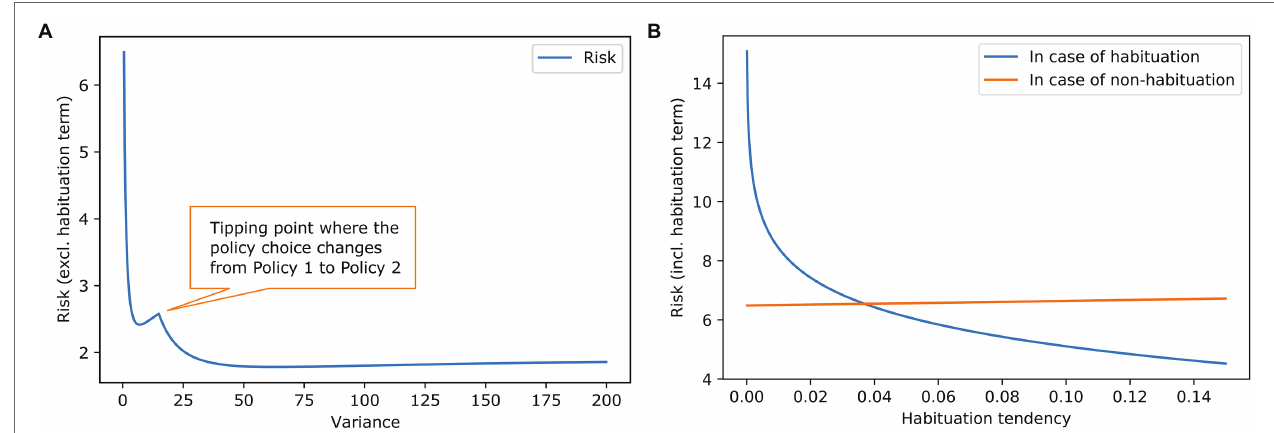
FIGURE 2 | Work stimulus scenario—effect of goal prior variance and habituation tendency on risk. (A) The blue line shows the risk term (excluding the habituation costs) dependent on the variance of the goal prior. We exclude the cost of habituation to show the influence of the goal prior shape on the policy choice. It can be seen, that risk is reduced if the goal prior is progressively flatter, because of the high mismatch between goal prior and attainable states in the policies. There is a tipping point where the policy choice for the agent changes. (B) The lines show the complete risk values (including the habituation costs) in case of habituation (blue) and in case of no habituation (orange) dependent on the habituation tendency. It is clear that risk for habituation gets smaller when the habituation tendency gets higher because the penalty for habituation is reduced. The orange line remains relatively constant which is intuitive because in case of no habituation the goal prior is not affected, and the penalty is not reduced. However, there is a slight increase in risk. This is due to our assumption that the agent strictly infers to not habituate. Before the inference, the agent had a (very) small preference for habituation which can be interpreted as a small value for keeping the option open. In the posterior q ( h ) though, the option is gone [in case of no habituation, it is q ( h ) = 0]. A higher habituation tendency h  means a higher value for the option to habituate thus resulting in an increase of the orange line, where this option is